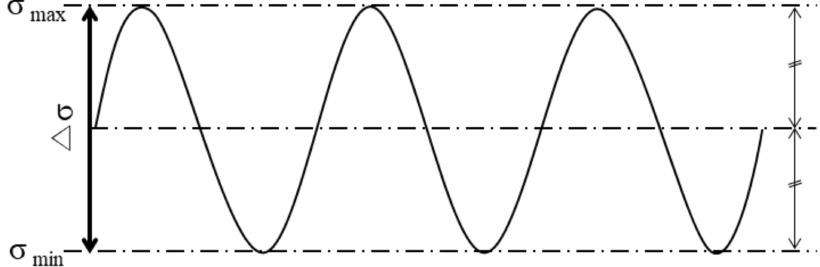
Figure 5. Schematic diagram of stress loading during the fatigue